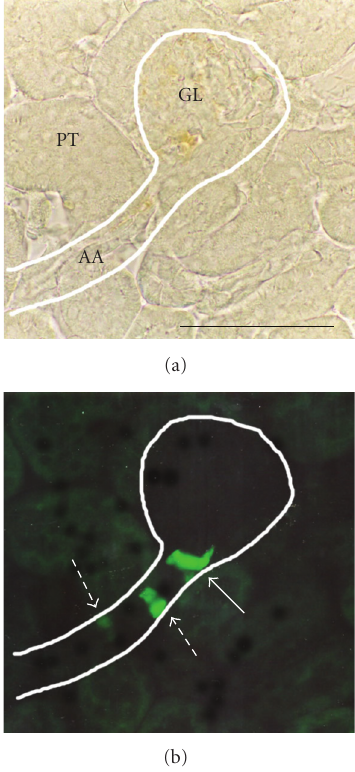
Figure 3: Light micrographs of a cryostat kidney section. Renal tissue was obtained from a transgenic heterozygous (Ren 1 d -GFP/ + ) adult mouse in which green fluorescent protein (GFP) was placed under the control of the Ren 1 d renin locus by homologous recombination [25, 72]. Renin synthesis was stimulated by a 7- day-treatment with the angiotensin II type-1 receptor antagonist, losartan (25 mg/kg per day). (a ) brightfield view showing the outline of an a ff erent arteriole (AA) and a glomerulus (GL) among proximal tubules (PT). (b) fluorescence view of the same field (white outline) showing green GFP signal from renin-synthesizing cells at the glomerular vascular pole (single arrow), and from upstream recruited cells (dashed arrows). Bar: 100 μ